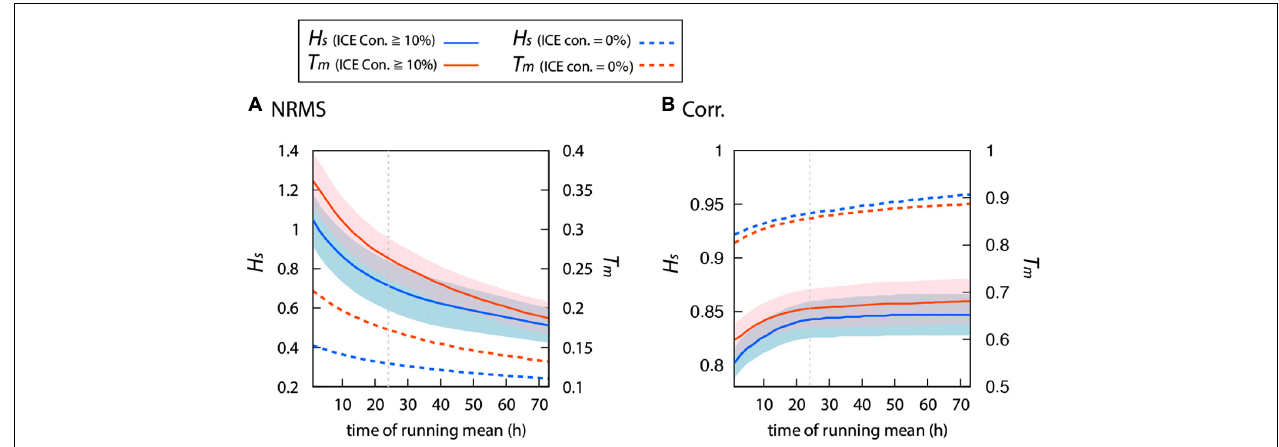
FIGURE 9 | (A) Normalized RMSE and (B) correlation coefficient from ST6 model simulations versus the buoy observation, as a function of time of running mean in 2 h bin. As shown in the legend in the upper corner, solid (broken) lines show the values for the ice-covered condition (open water condition) for H s (blue) and T m r P(cid:16) (cid:17) 2 / X s − X o − bias n , where X s is the simulation result, X o is the observation data, and n is the (red), respectively. In this figure, the normalized RMSE is defined as X o number of data points. The ice-covered condition result shows the average from all model simulations (i.e., ten modeled results in Figure 4 or Table 1 ). The color shading indicates the standard deviation of ten modeled simulations. The IC1 simulation result is used for the open water condition. 24 h is highlighted by the gray broken